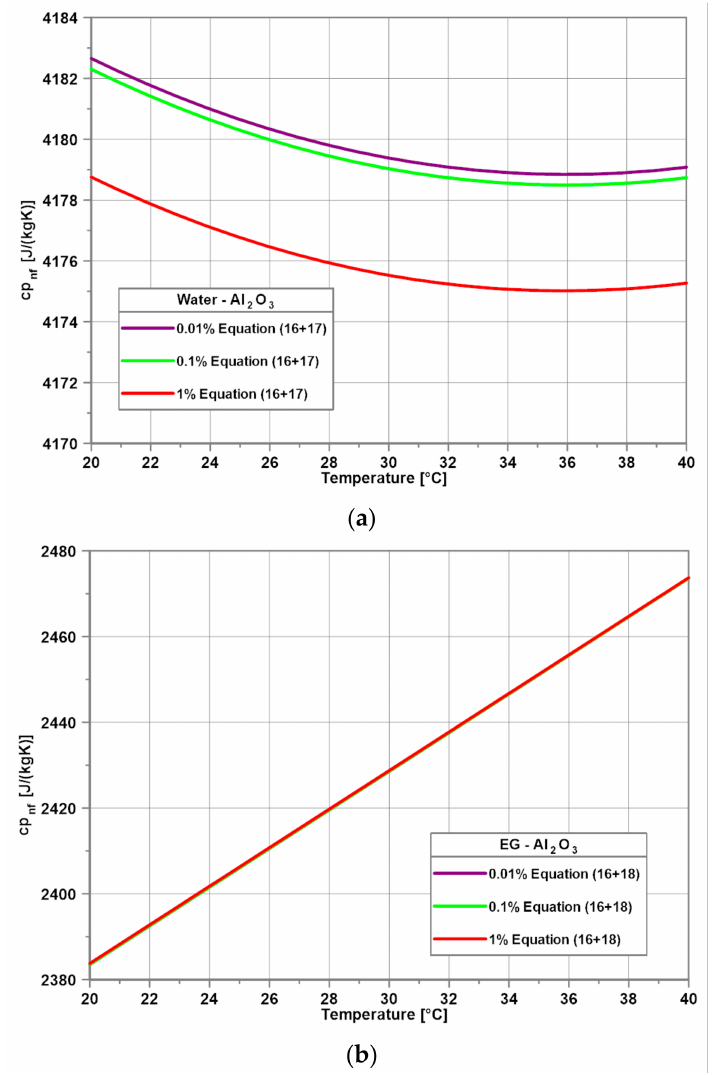
Figure 4. Specific heat of the water-based ( a ) and EG-based ( b )